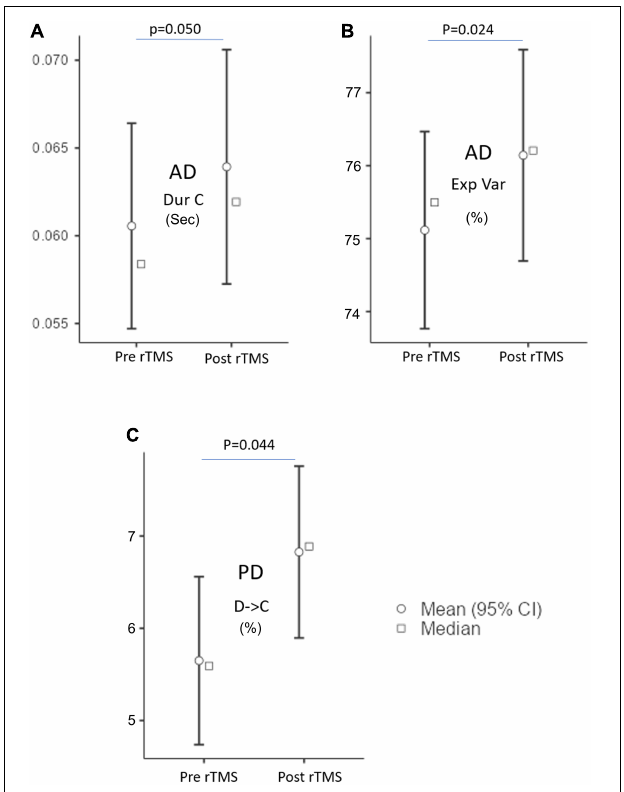
FIGURE 4 | The microstate parameters which are (A) duration (Dur), (B) explained variance (Exp Var) of AD, and (C) transition of D to C of PD groups at pre-rTMS and post-rTMS. p <